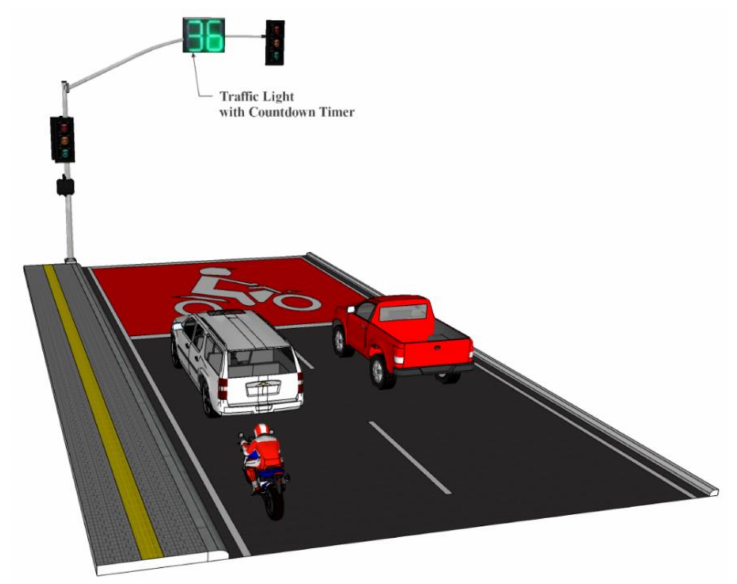
Figure 3. Red box for motorcycles that has a traffic light with a countdown